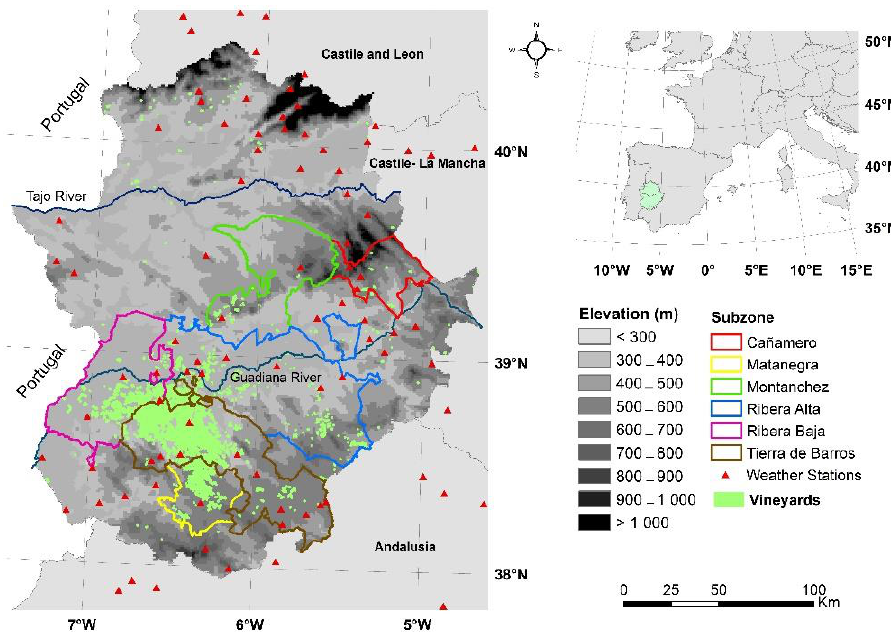
Figure 1. Location map of Extremadura. Digital elevation model, vineyards, weather stations, and subzones of the Ribera del Guadiana Protected Denomination of Origin are shown.